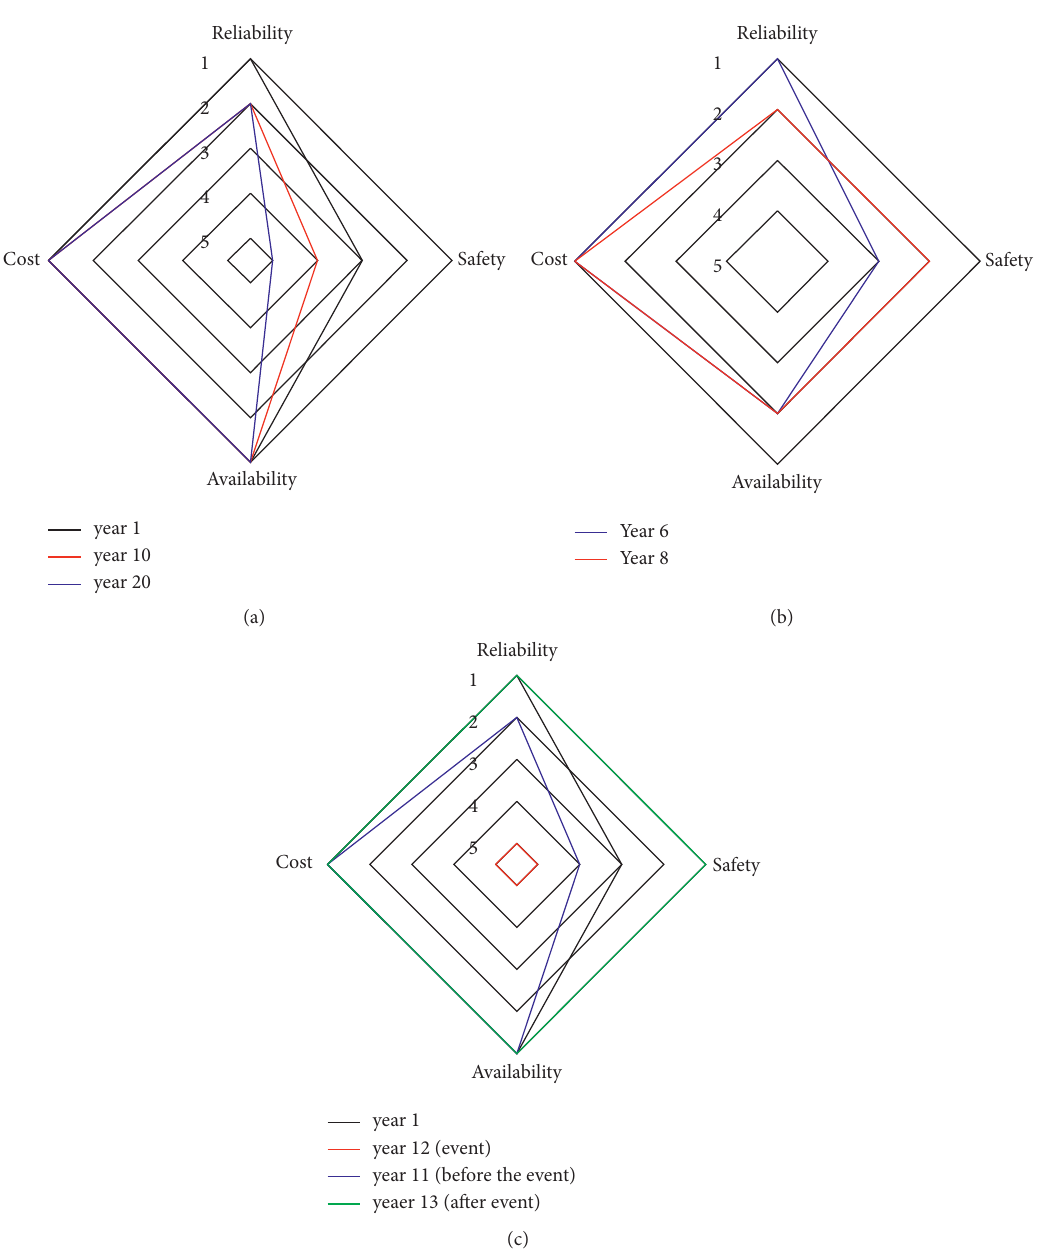
Figure 12: Bridge performance condition in different scenarios: (a) natural; (b) preventive; (c)